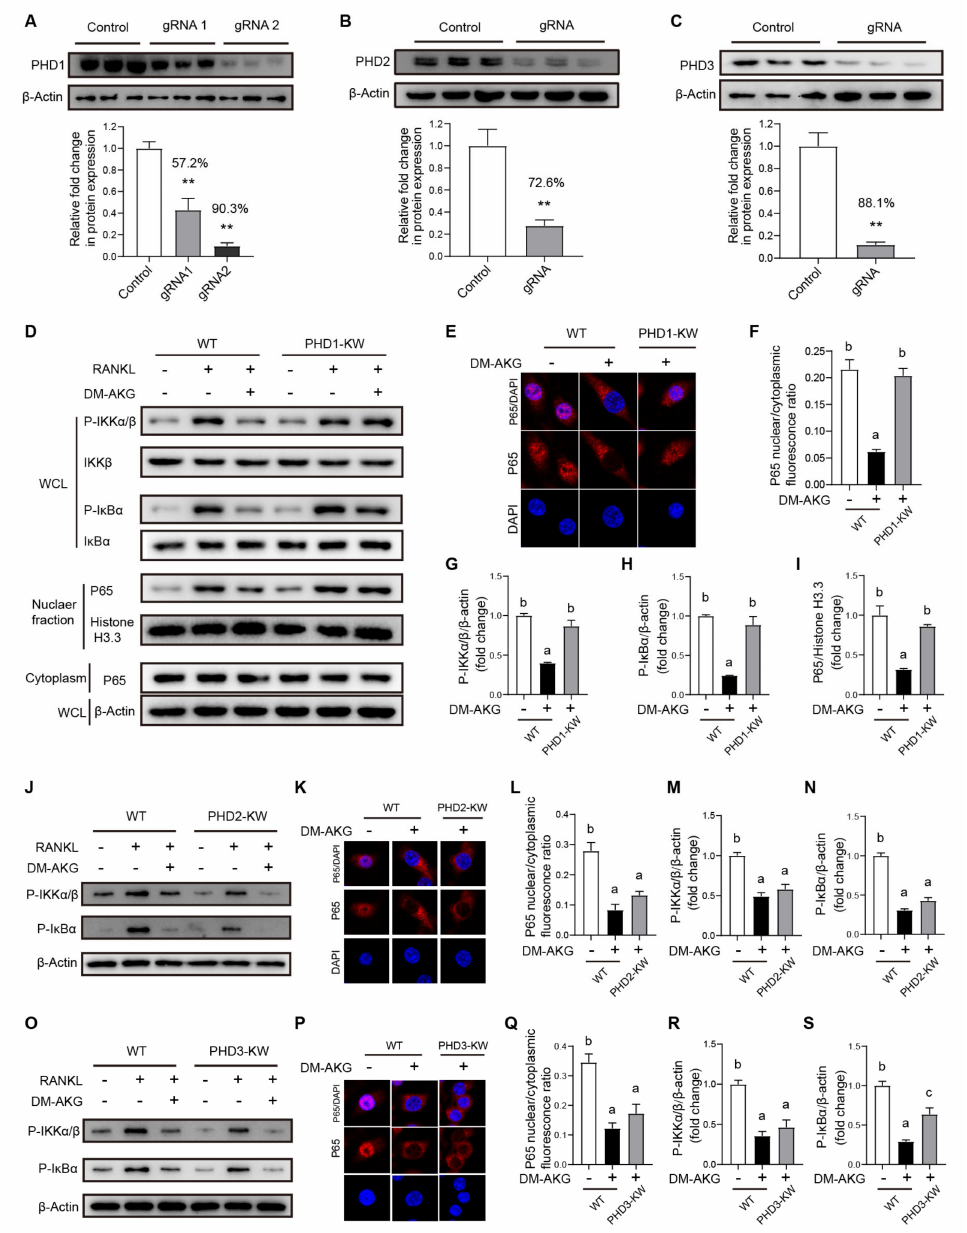
Figure 5. Blocked PHD1 expression reverses the inhibitory effects of DM-AKG on NF- κ B signaling pathway during osteoclast differentiation. ( A ) The knock-out efficiency of PHD1 in two monoclonal cell lines determined by WB ( n = 3). The knock-out efficiency of ( B ) PHD2 and ( C ) PHD3 in mon- oclonal RAW264.7 cell line determined by WB ( n = 3). ( D ) Immunoblot analysis of nuclear and cytoplasm P65, P-IKK α / β , IKK β , P-I κ B α , and I κ B α in WT and PHD1 deficiency cells treated with or without DM-AKG (5 mM) for 3 h and then stimulated with or without RANKL for 30 min. Represen- tative images of immunofluorescence for P65 ( E ) and quantitative immunofluorescence results of P65 nuclear translation ( F ) in WT and PHD1 deficiency cells treated with or without DM-AKG (5 mM) for 3 h and then stimulated with RANKL for 30 min ( n = 3). Quantitative results of immunoblot of nuclear P65 ( G ), P-IKK α / β ( H ), and ( I ) P-I κ B α in WT and PHD1-deficiency RAW264.7 cells ( n = 3). ( J ) Immunoblot analysis of P-IKK α / β , IKK β , P-I κ B α , and I κ B α in WT and PHD2 deficiency cells treated with or without DM-AKG (5 mM) for 3 h and then stimulated with or without RANKL